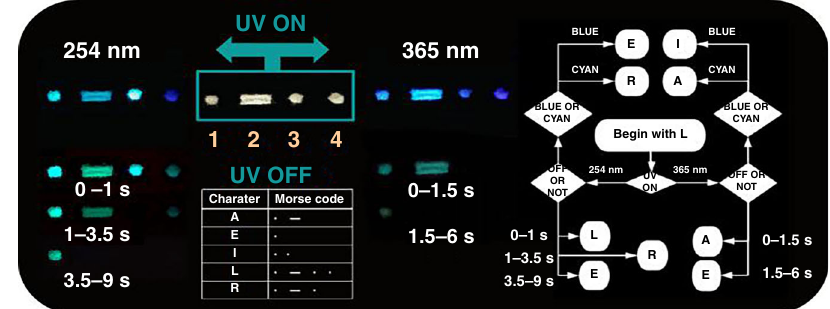
Fig. 6 Schematic diagram of the information encryption and decryption processes. (1) (Ph 4 P) 2 Cd 2 Cl 6 , (2) (Ph 4 P) 2 CdCl 4 , (3) (Ph 4 P) 2 Cd 2 Br 6 , and (4) (Ph 4 P) 2 CdBr 4